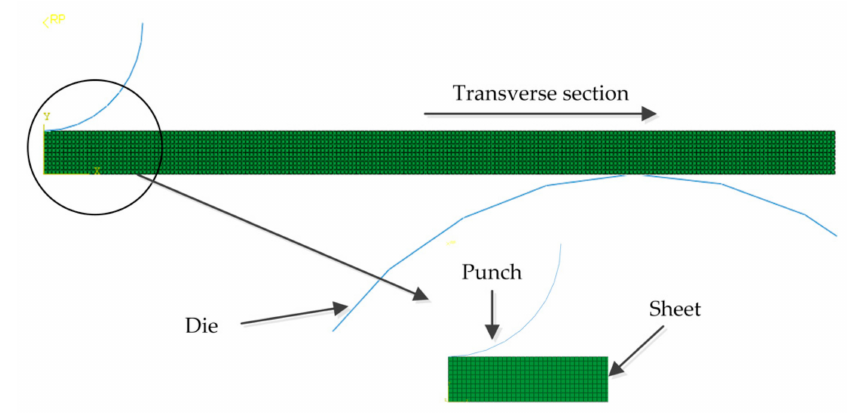
Figure 2. Finite element prediction